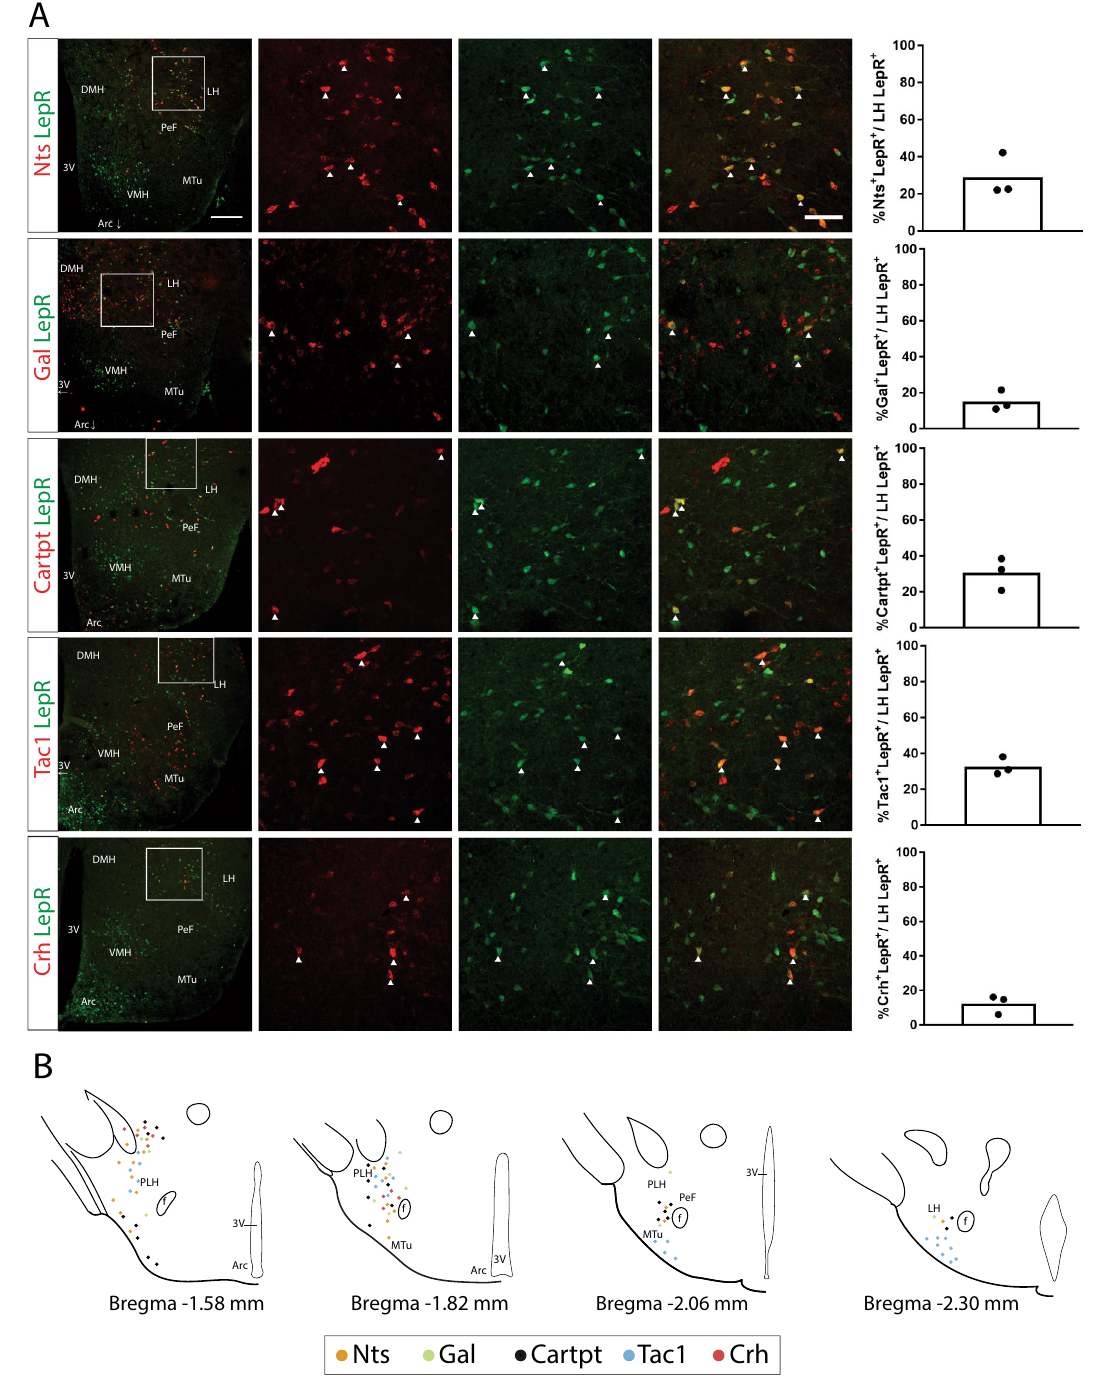
Figure 2. Expression of neuropeptides in LepR LH cells and co-localization patterns in the LH. ( A ) Fixed coronal sections from LepR-Cre x L-tdTomato mice underwent fluorescent in situ hybridization (FISH) with anti-sense RNA probes for Nts , Gal , Cartpt , Tac1 and Crh (" Neuropeptide "—red channel) followed by immunohistochemistry (IHC) for tdTomato ("LepR"—green channel) and imaging. The percentage of Neuropeptide + LepR + cells out of the total LepR + in the LH was quantified, as represented in the barplots (mean, n = 3 hypothalami). ( B ) Localization of Neuropeptide + LepR + cells was observed under the microscope and drawn on representative graphic images of coronal sections from the mouse Brain Atlas 58 , which were adapted for this figure. Arc: Arcuate nucleus of the Hypothalamus, 3 V: 3rd Ventricle, DMH: Dorsomedial Hypothalamus, VMH: Ventromedial Hypothalamus, LH: Lateral Hypothalamus, PeF: Perifornical area, f: Fornix, MTu: Medial Tuberal